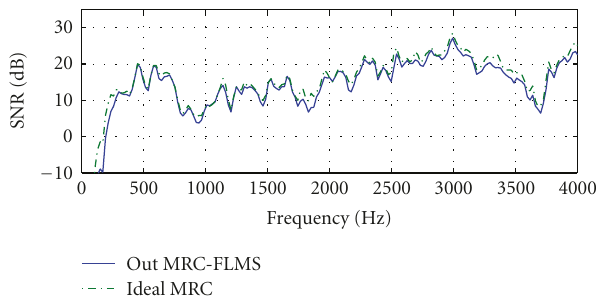
Table 4: Cosh spectral distances for di ff erent combining tech- niques—short/tall